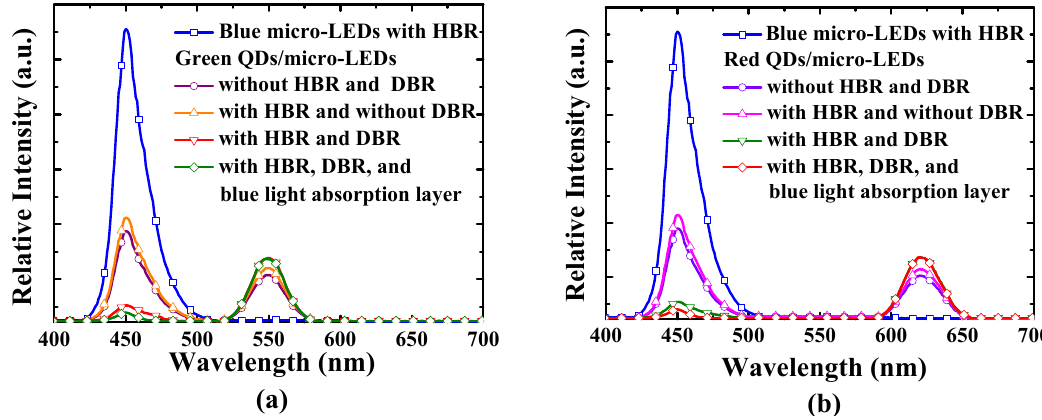
Figure 6. The EL spectra of the resulting ( a ) green QDs/micro-LEDs and ( b ) red QDs/micro-LEDs.